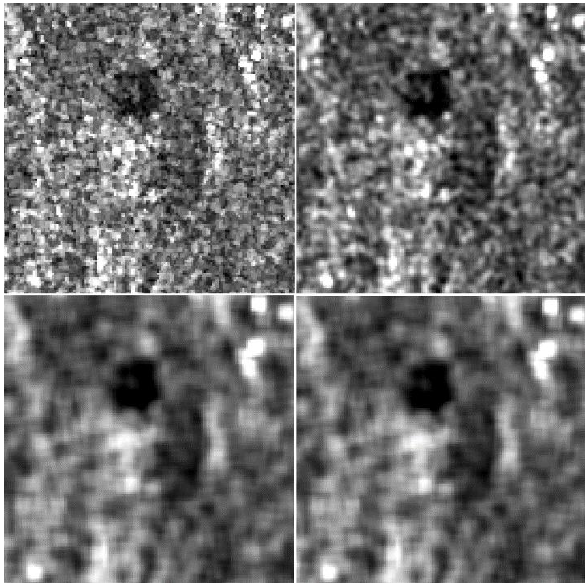
fan south of the city of Kokand (districts Uchkuprik, Baghdad